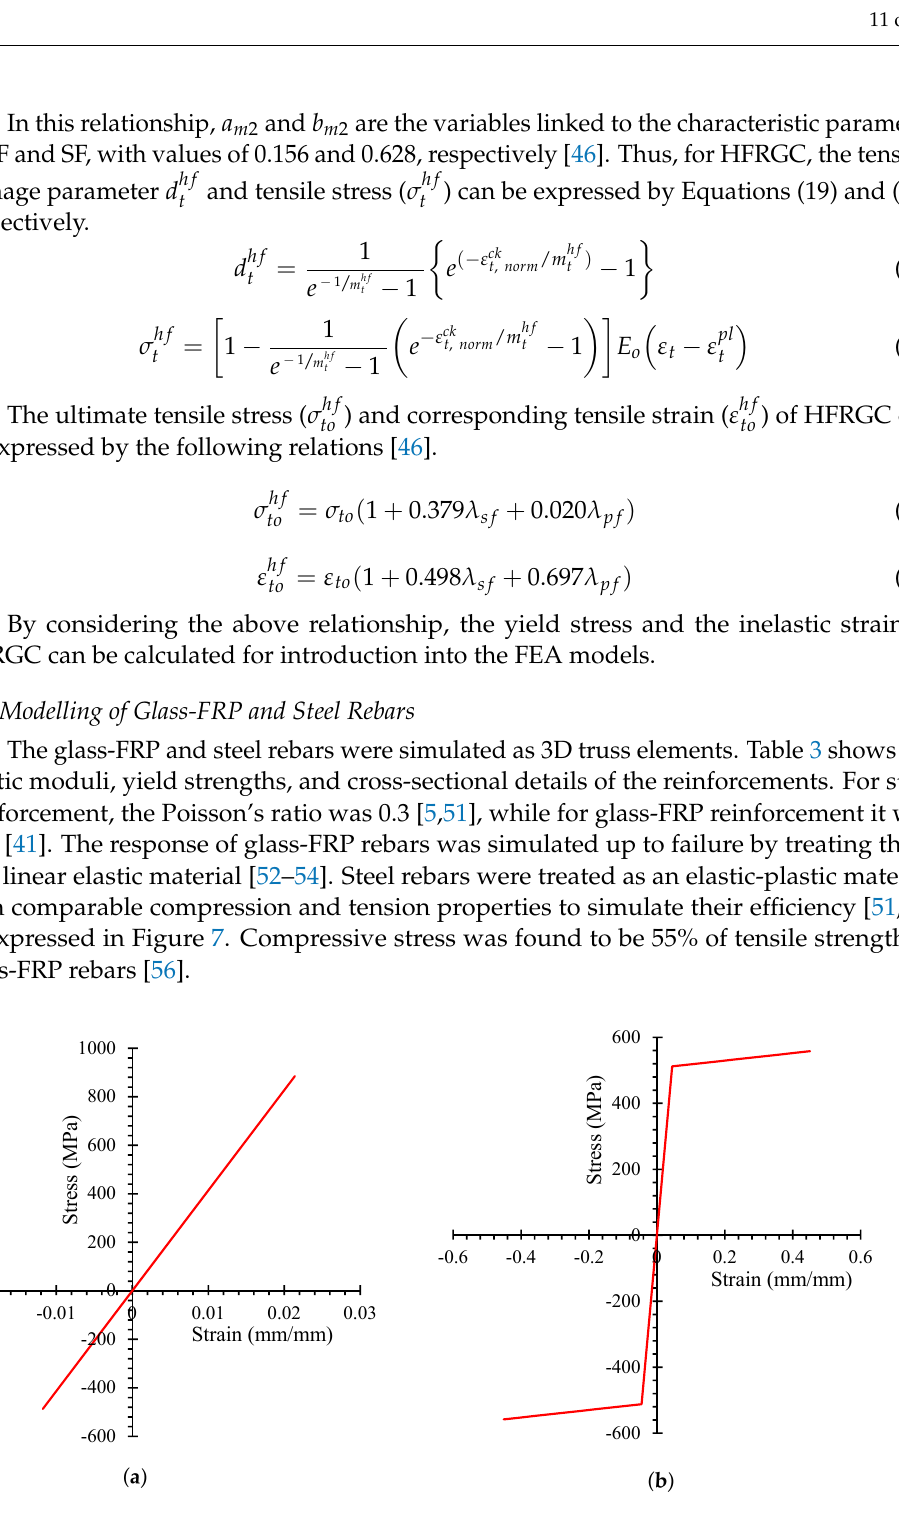
Figure 7. Reinforcement behaviors ( a ) linear elastic efficiency of glass-FRP rebars ( b ) elastic-plastic efficiency of steel rebars.